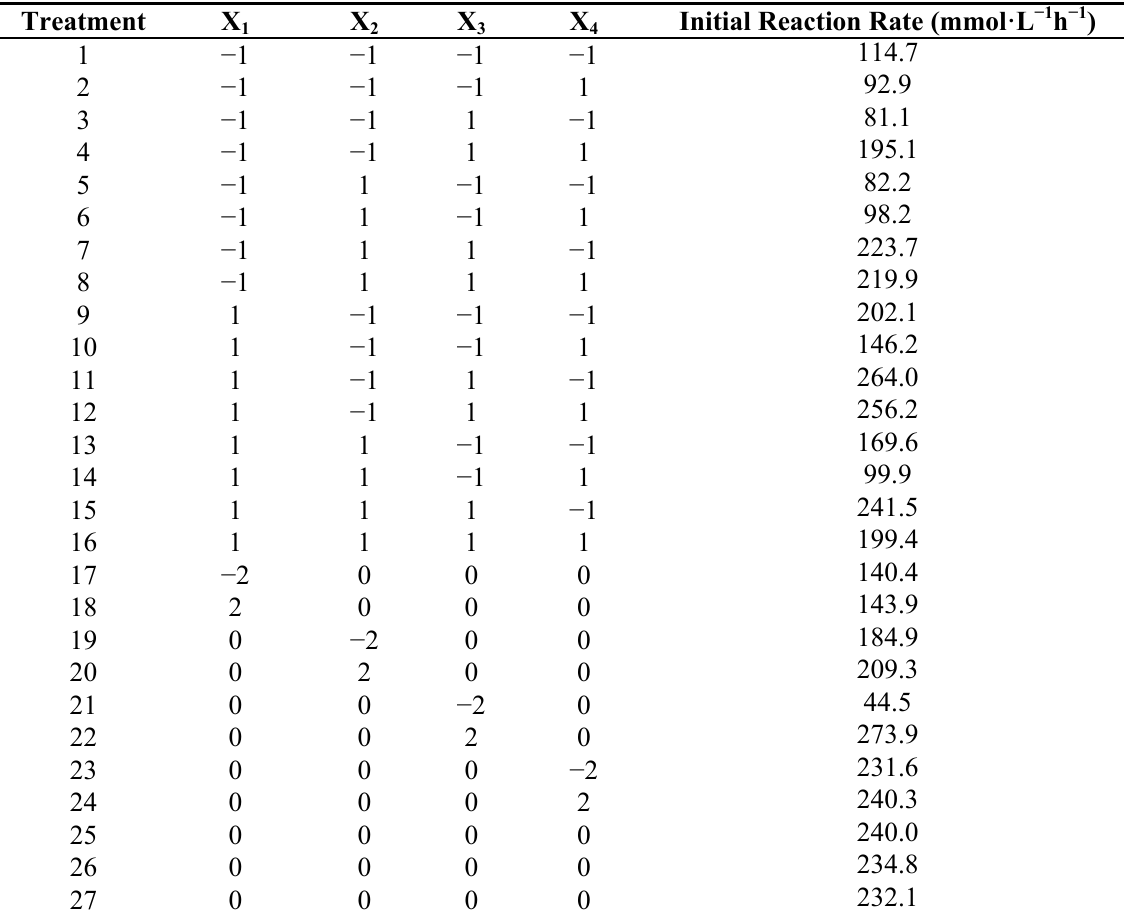
Table 1. Experimental design and results of